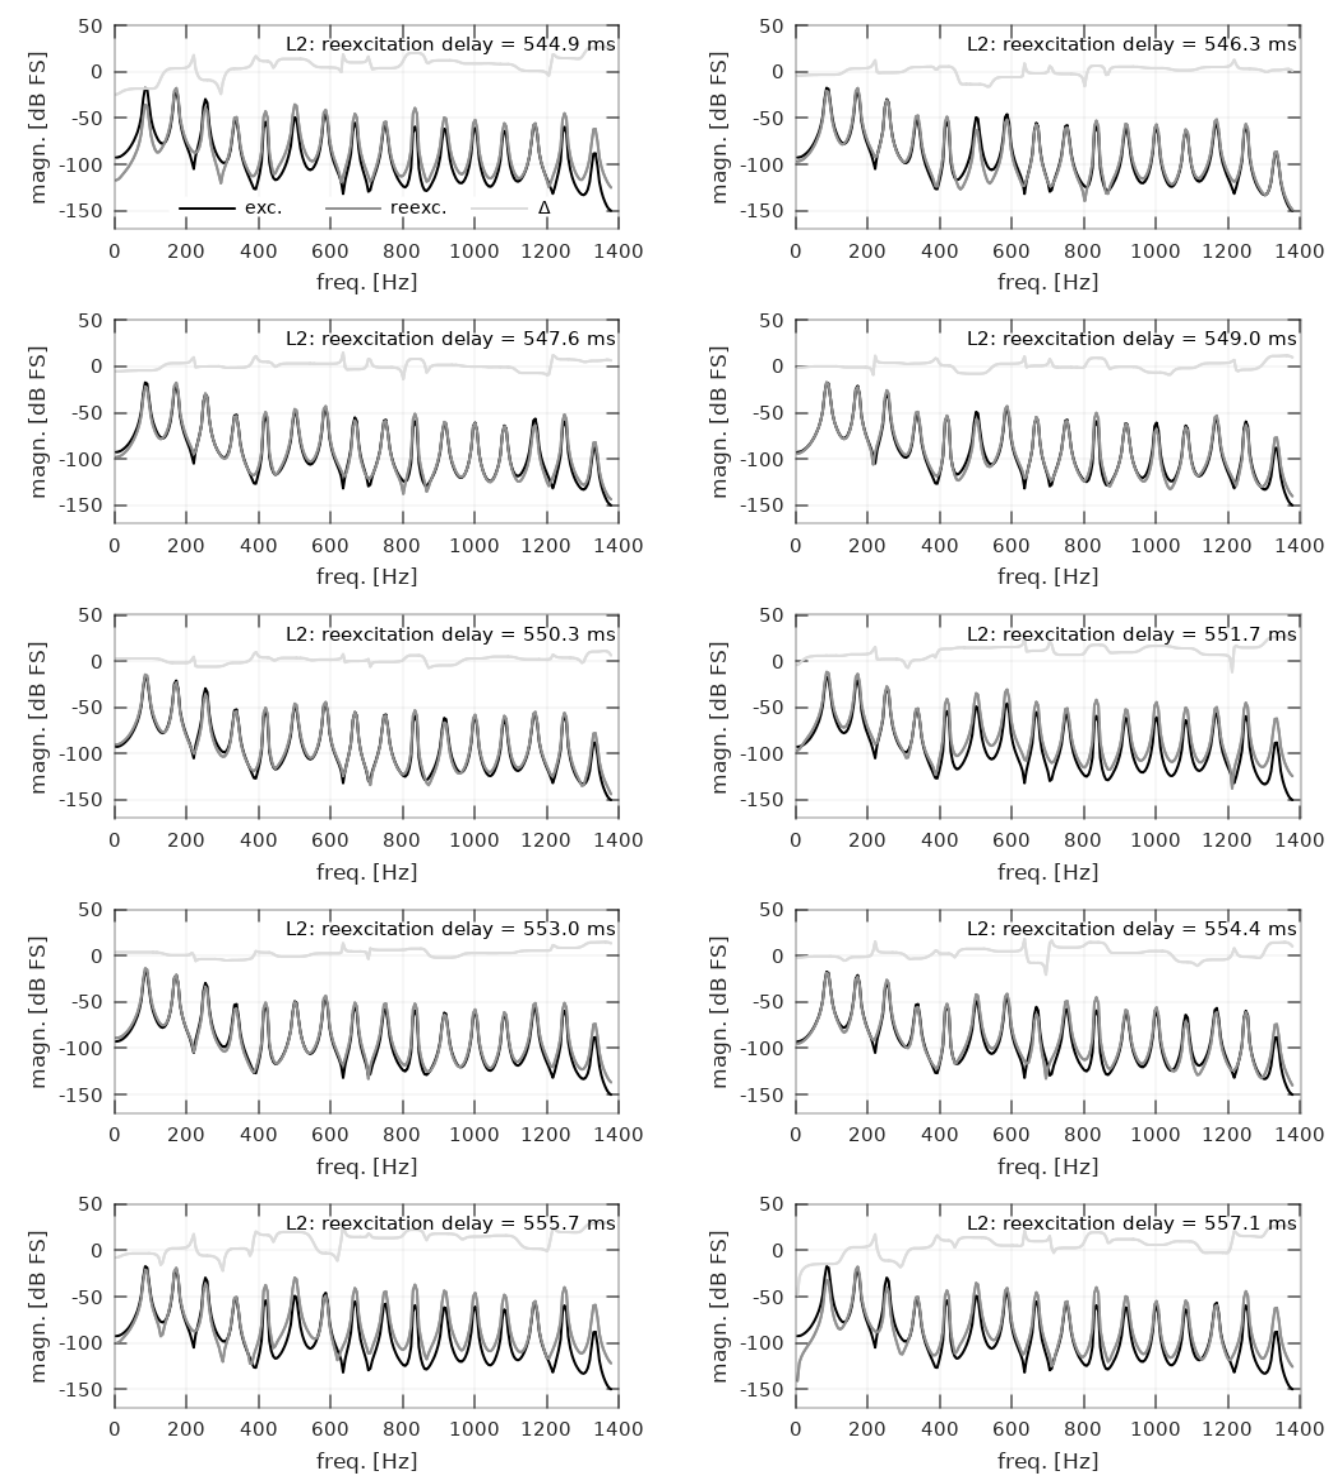
Figure 9. Simulation L2—spectra of primary excitation (dark plot) and re-excitation (medium) for all simulated delays; ∆ (light) represents spectral